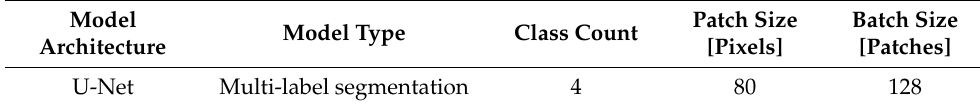
Table 2. Input parameters for the Deep Learning Tool of the software